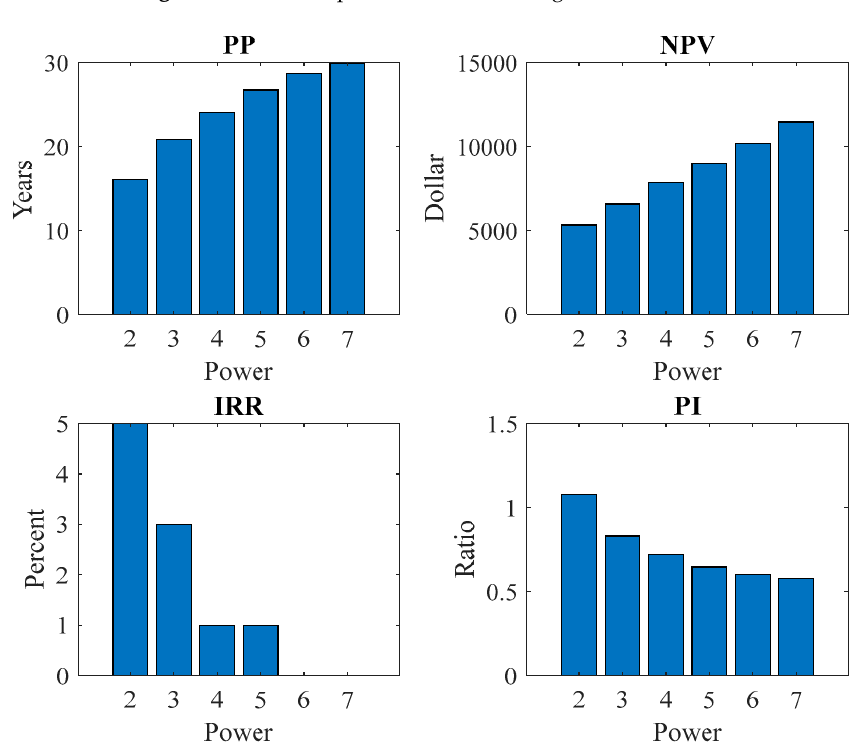
Figure 9. Economic parameters of building 2 in the state Figure 9 Economic parameters of building 2 in the state A.